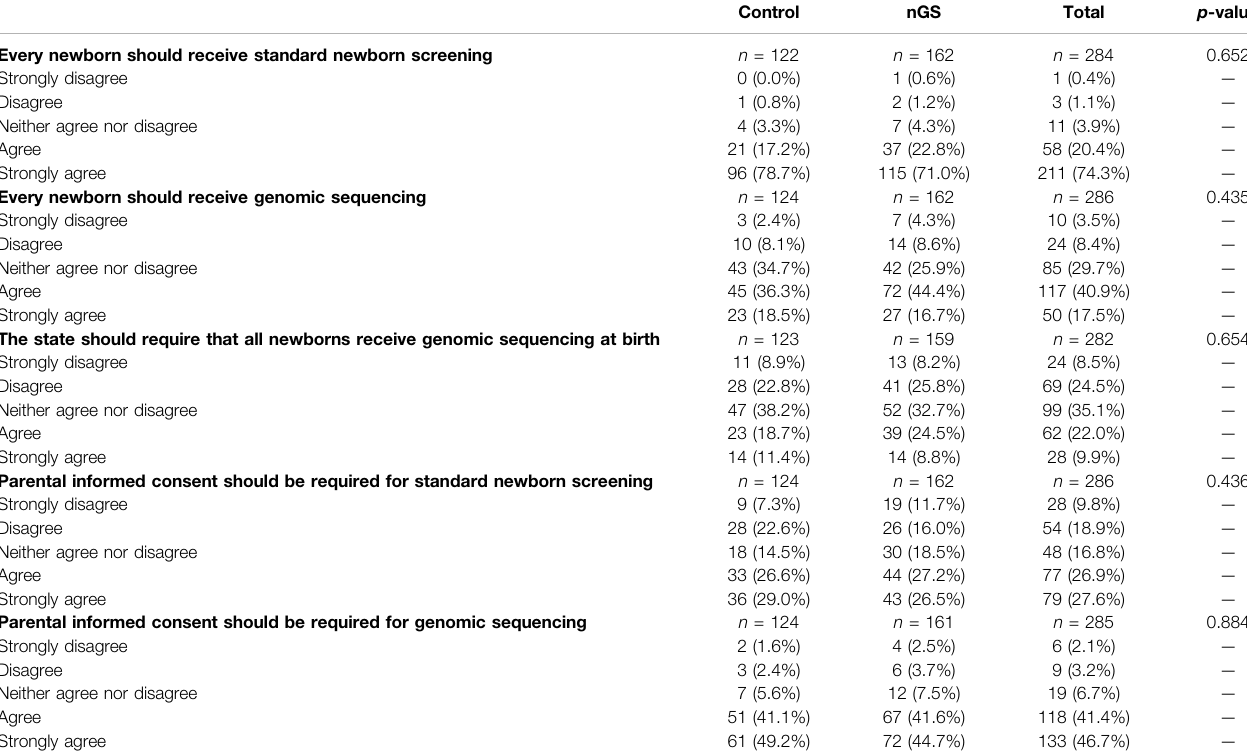
TABLE 2 | Parents ’ attitudes regarding standard newborn screening and newborn genomic sequencing by study